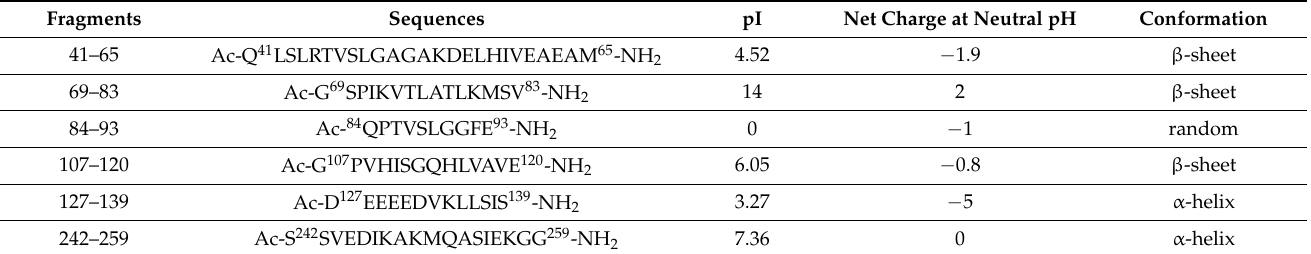
Table 1. NPM1 fragments analyzed in this study: peptide sequences, pIs, conformation in NPM1 structure.